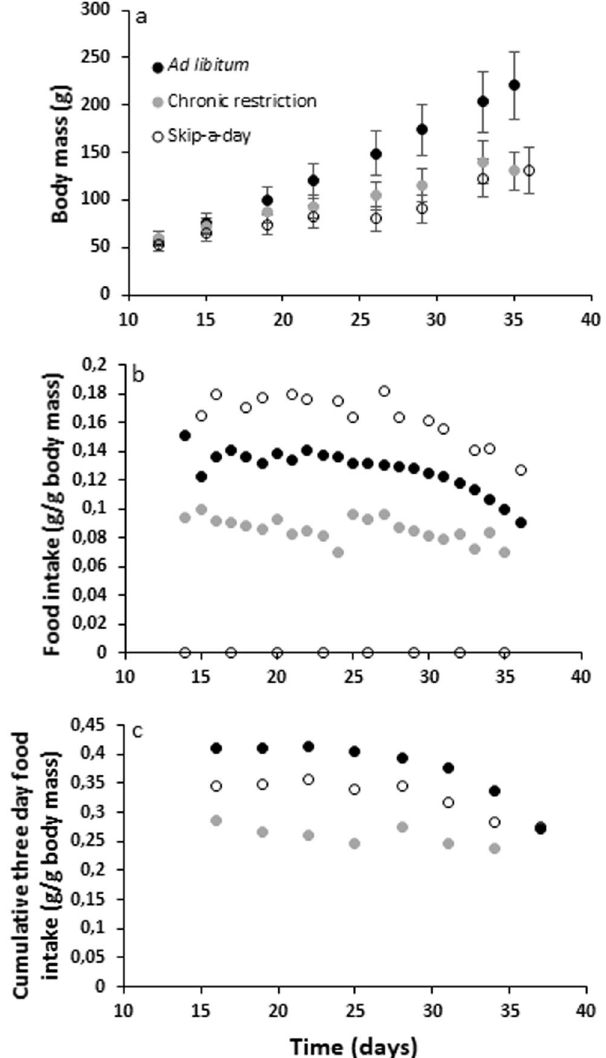
Figure 1. Body mass trajectories ( a ), food intake ( b ) and cumulative food intake ( c ) of Red Junglefowl chicks reared under ad libitum feeding (AL, black circles), chronic feed restriction (CR, grey circles) and skip-a-day feeding (S, open circles). Final body masses were higher in AL birds (N = 48) in comparison to CR (N = 48) and S birds (N = 43) as determined using two-way ANOVA. Error bars represent standard deviations of the